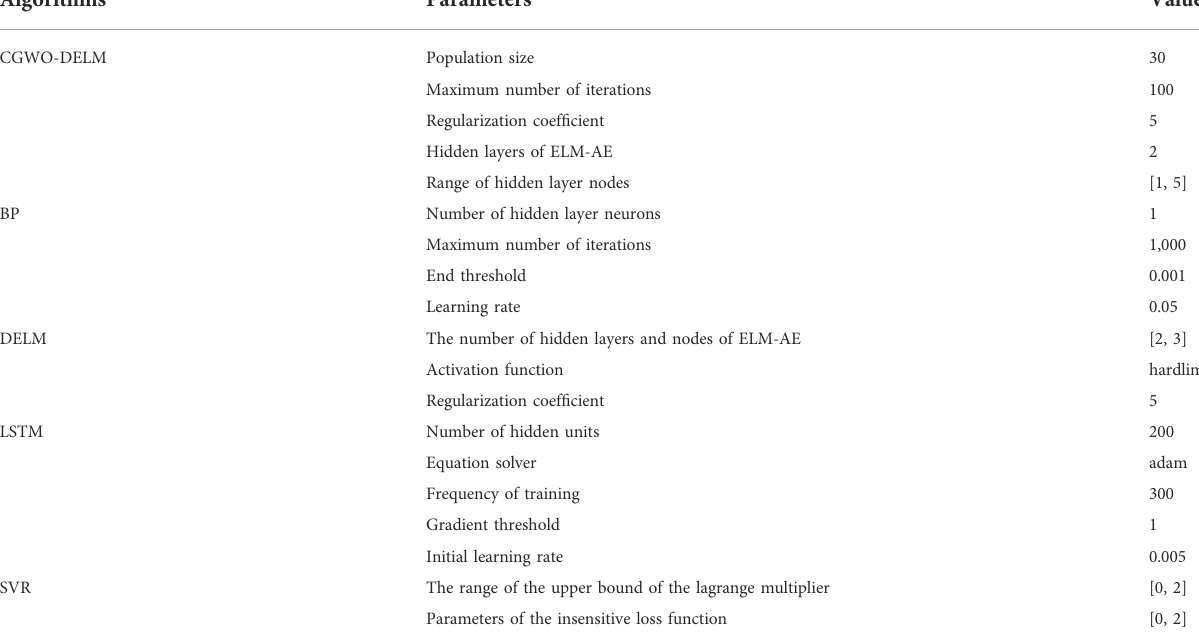
TABLE 3 Parameter setting of the algorithm.